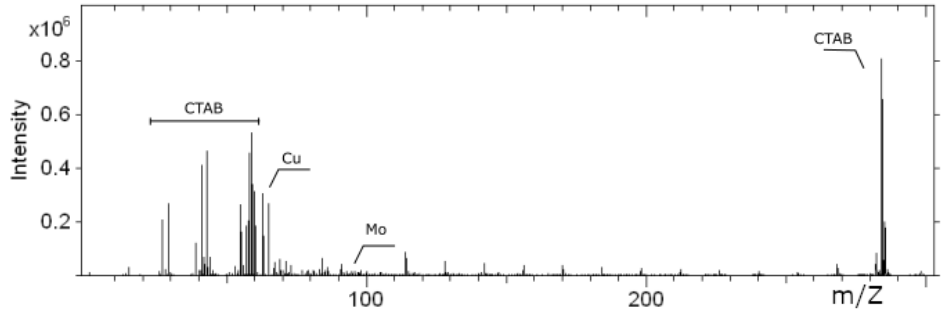
Figure 5. TOF-SIMS ions with masses at the range of m / z 0 to 300 measured on the surface of a stainless steel AISI 316L coated with a Cu–MoS 2 composite coating.